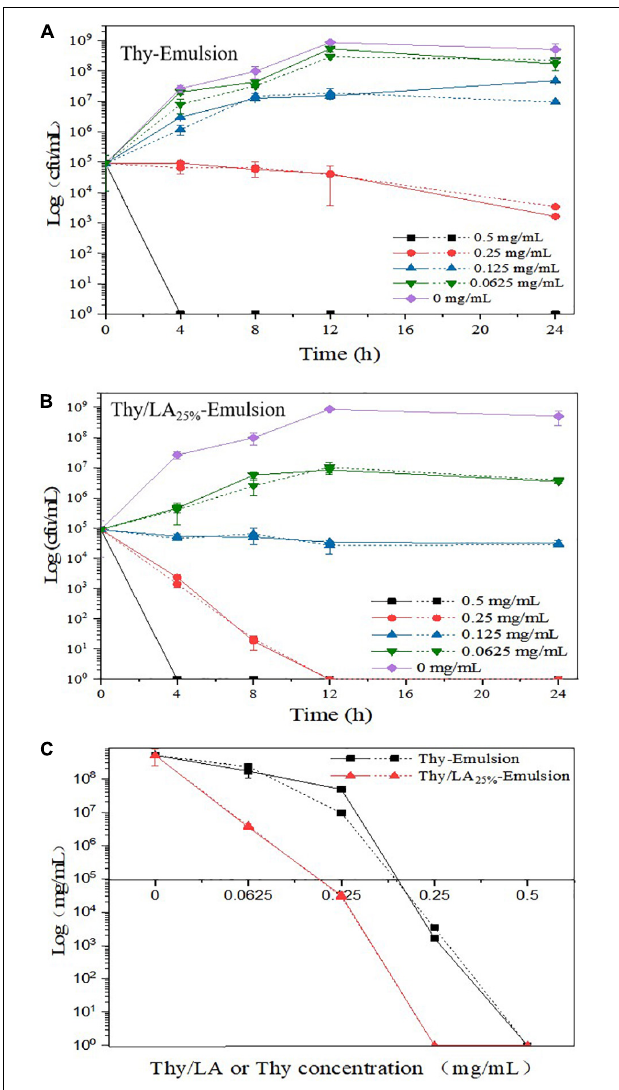
FIGURE 7 | The growth curves of Thy-Emulsion (A) and Thy/LA 25% -Emulsion (B) incubated for 24 h at 37 ◦ C and (C) the number of colonies formed in Thy-Emulsion and Thy/LA 25% -Emulsion after 24 h (the concentration of Thy or Thy/LA ranged from 0.625 to 0.5 mg/mL). The solid line represents the 0th day, and the dashed line represents the 30th day. n =